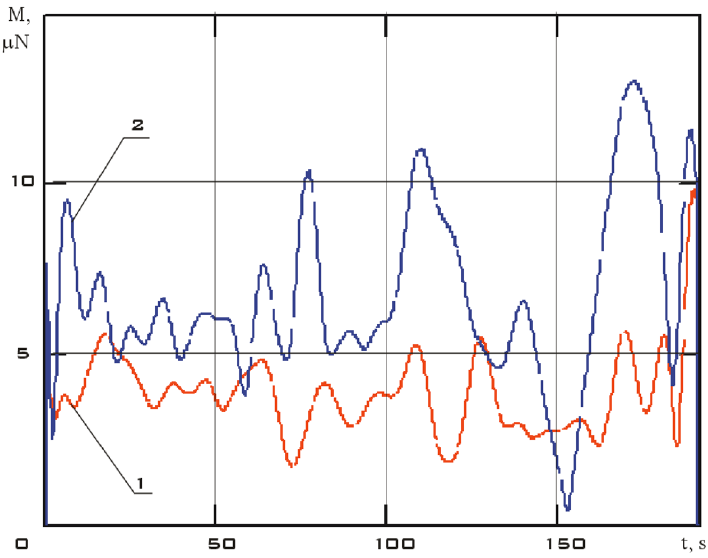
Figure 14. There are modulus of the disturbing moment in the coordinate system CXYZ . 1—01/11/2014 from 01:45:14 to 01:48:20; 2—01/14/2014 from 04:41:15 to 04:44:21.